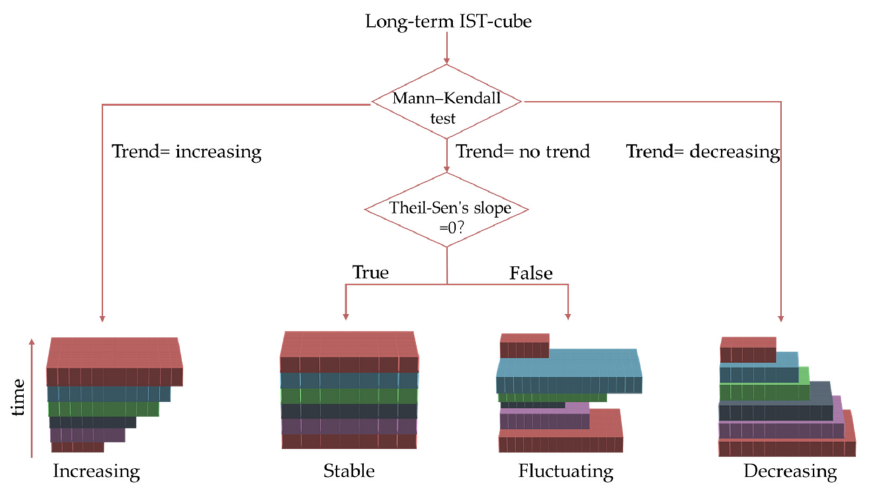
Figure 5. Flow diagram of the long-term IST-cube classification. The cube in the figure has different colors for different years. The cubes that appear in the following figures are all the same.